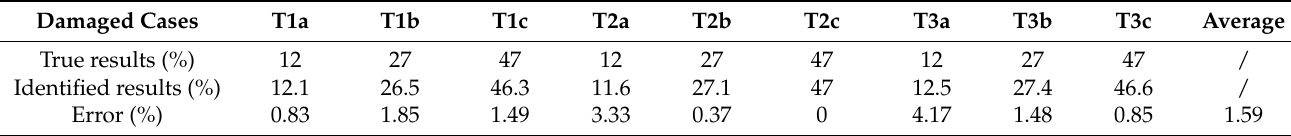
Figure 9. Damage curves: beam 1; beam 2; beam 3. Table 3. Damage identifications results.